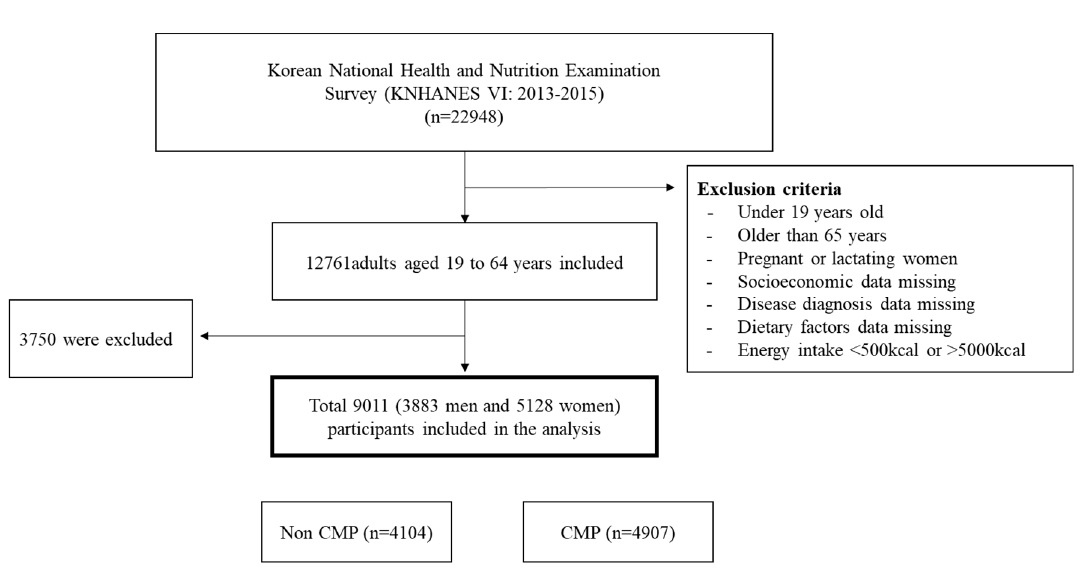
Figure 1. Flow chart for participant selection. KNHANES: Korean National Health and Nutrition Examination Survey; CMP: Cardiometabolic multimorbidity pattern.